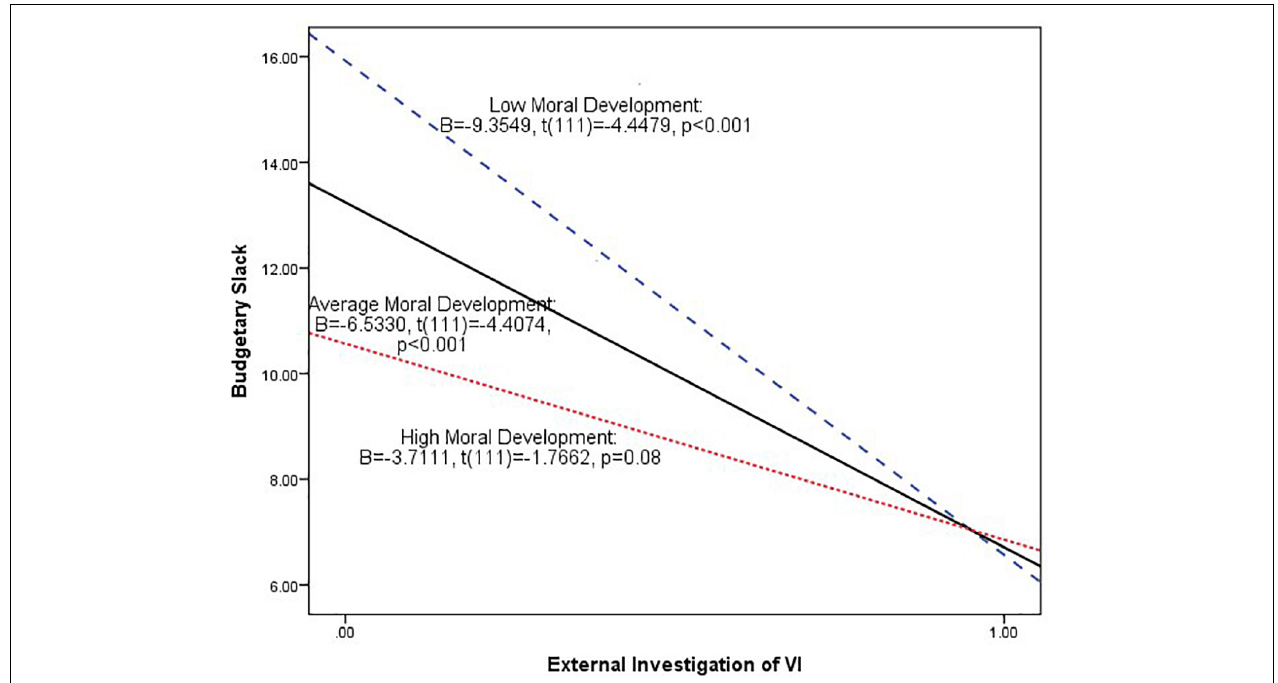
FIGURE 3 | Plot of the predicted value of budgetary slack at external investigation of VI at low, average, and high levels of moral development. The average, low, and high level of moral development are defined according to the mean, mean + 1.0 standard deviation, and mean − 1.0 standard deviation of moral development. The slope of each plotted line is the simple slope of external investigation of VI at the various values of moral development.